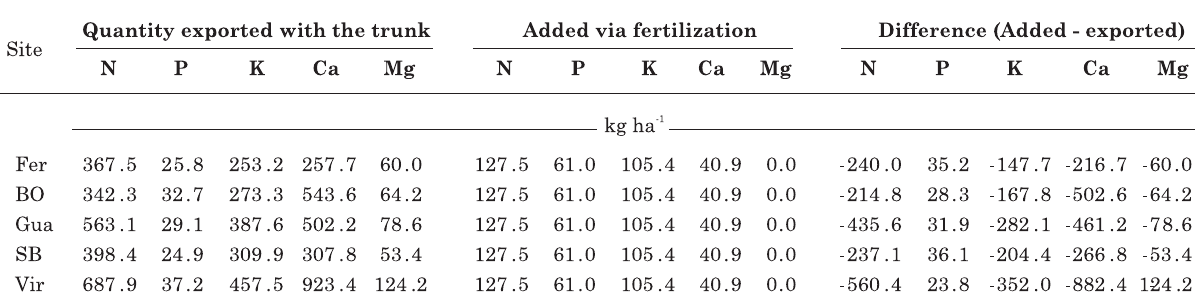
Table 3. Nutrient quantities exported with the trunks and applied to the system via fertilization in eucalyptus areas during three cycles (sums) in five studied regions of the Rio Doce